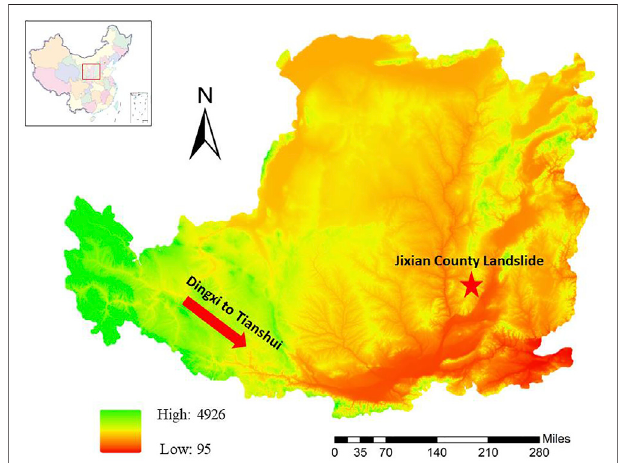
FIGURE 1 | Local loess distribution of China and cases sites.